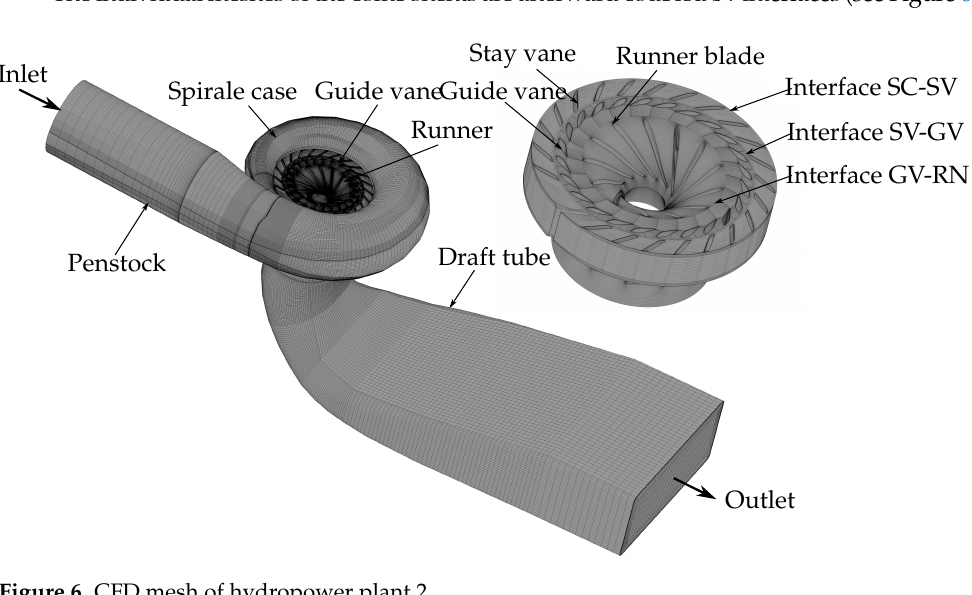
Figure 6. CFD mesh of hydropower plant